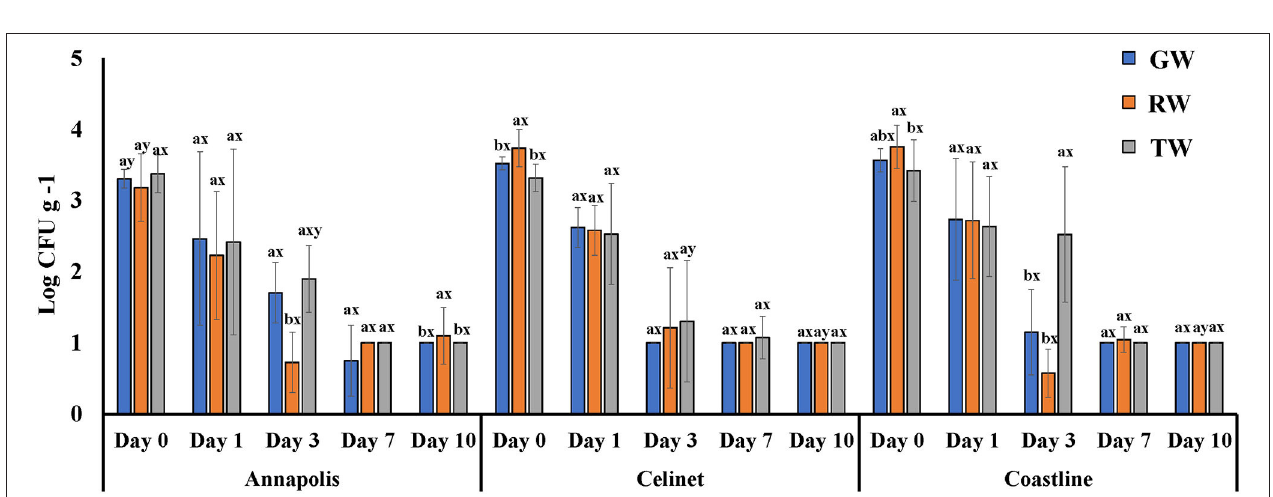
FIGURE 2 | Populations of E. coli K12 recovered from three cultivars of lettuce irrigated with groundwater (GW), roof-collected rain water (RW), and secondary-treated wastewater (TW). Three cultivars included “Annapolis,” “Celinet,” and “Coastline” and sampling time points were 0, 1, 3, 7, and 10 days-post-irrigation. Four replicate samples were analyzed per treatment group at each sampling time point ( n = 4). Error bars indicate the SD. ab Means of bacterial populations in the same sampling time point for the same lettuce cultivar with different letters are significantly different ( P < 0.05). xy Means of bacterial populations in the same time point on different lettuce cultivars irrigated with the same type of irrigation water with different letters are significantly different ( P <